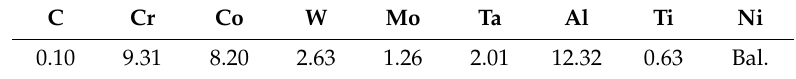
Table 2. Chemical composition of the DD98M single crystal superalloy (at.%).